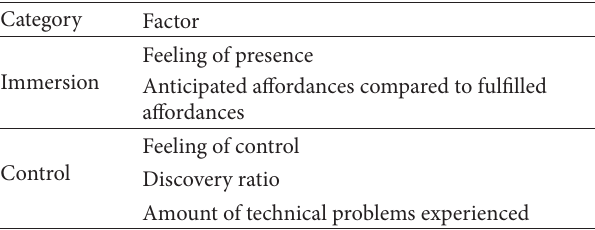
Table 2: Factors used to create authenticity